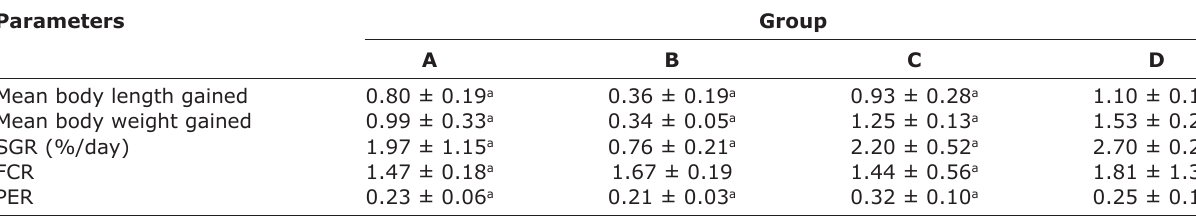
Table-3: Body length and weight gained during the duration of the study.